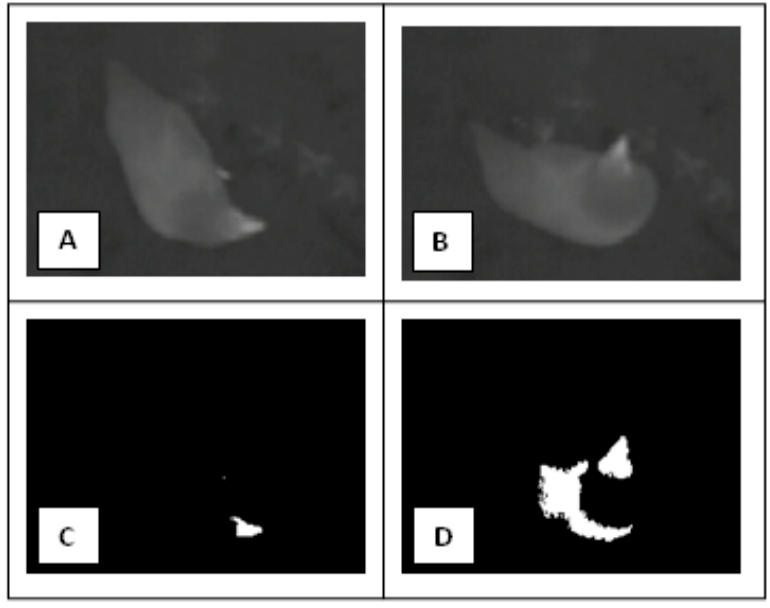
Figure 4. Pictures ( A , B ) are examples of the thermographic images collected during the experiment, while pictures ( C , D ) are examples of the elaborations performed by the monitoring system under study. In details, picture ( C ) is the result of the elaboration performed having as input the picture ( A ) while picture ( D ) is the result of the elaboration performed having as input the picture ( B ). In picture ( C ), the number of colored pixels (CP) is 113 while in picture ( D ), the number of CP is 1832. Therefore, considering a cutoff threshold of 196 pixels (“hens detected” threshold), picture ( C ) is